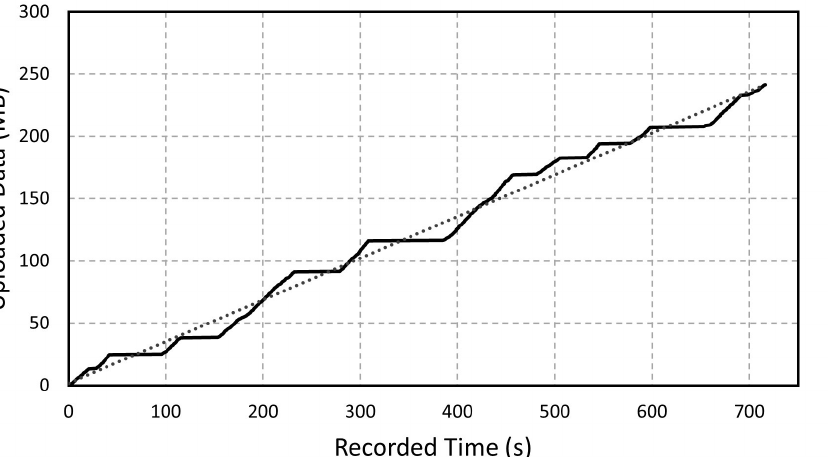
Figure 5. The number of bytes acquired, processed, and sent to the IoT server over time. The solid line represents the measured values and the dotted line represents the average